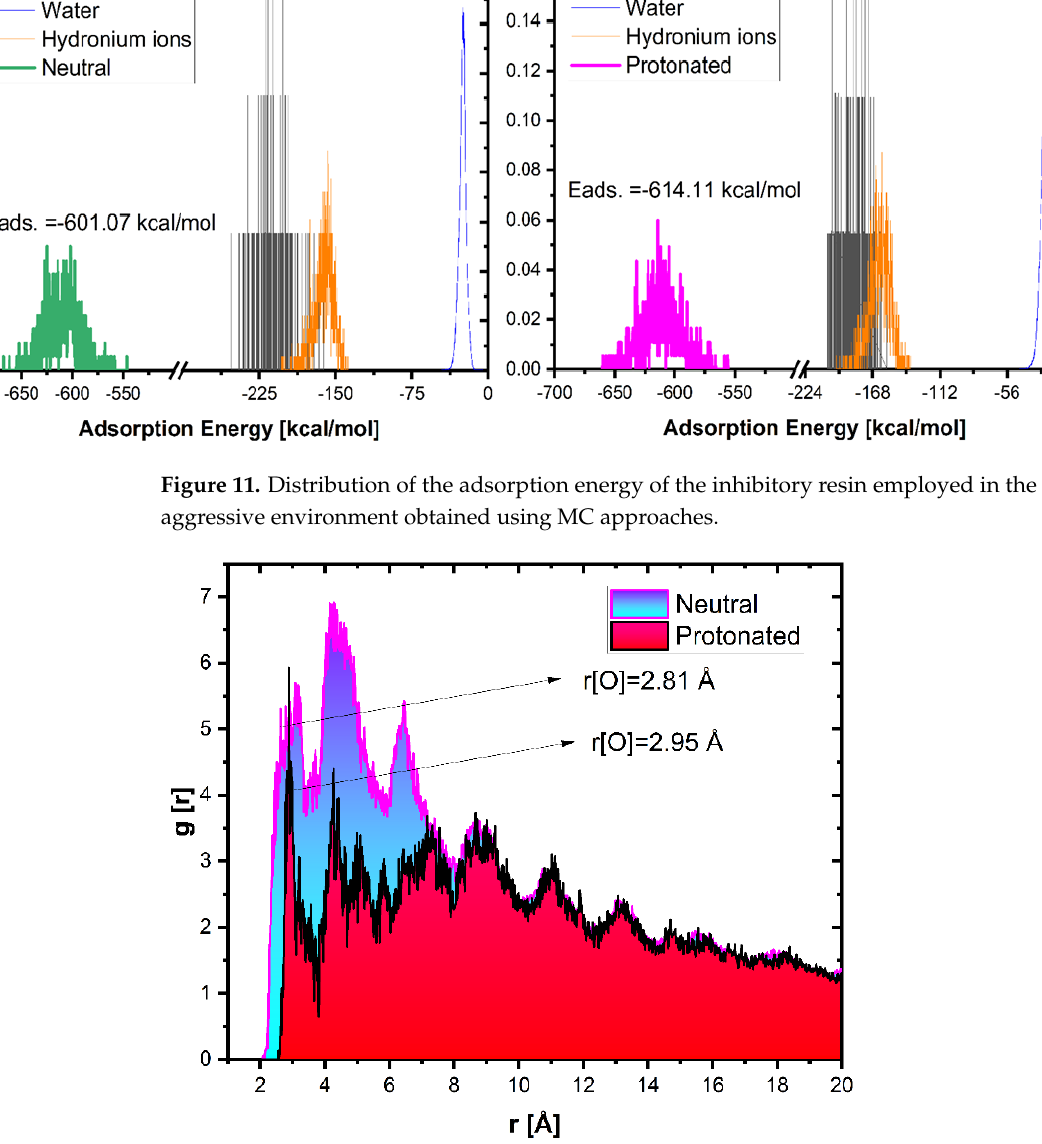
Figure 12. RDF oxygen atoms for the inhibitor (neutral and protonated) on the Fe (110) area accom- plished using MD trajectory approach.